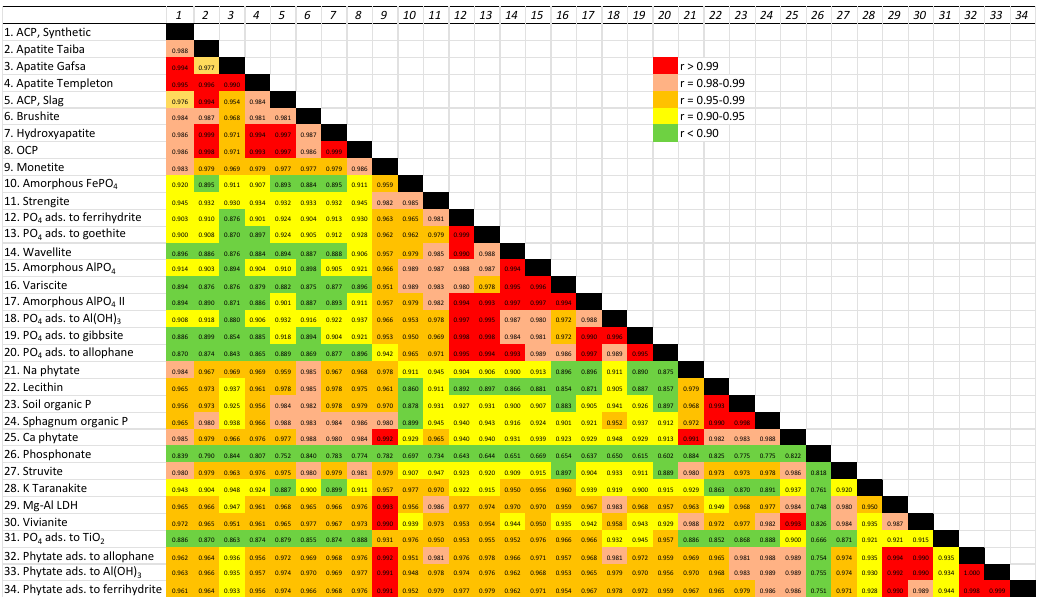
Figure 2. Correlation matrix for the P K-edge XANES spectra of the 34 standard samples considered. Data points ranging from − 10 to +30 eV relative to E 0 were included in the analysis. For abbreviations, see Table S1.